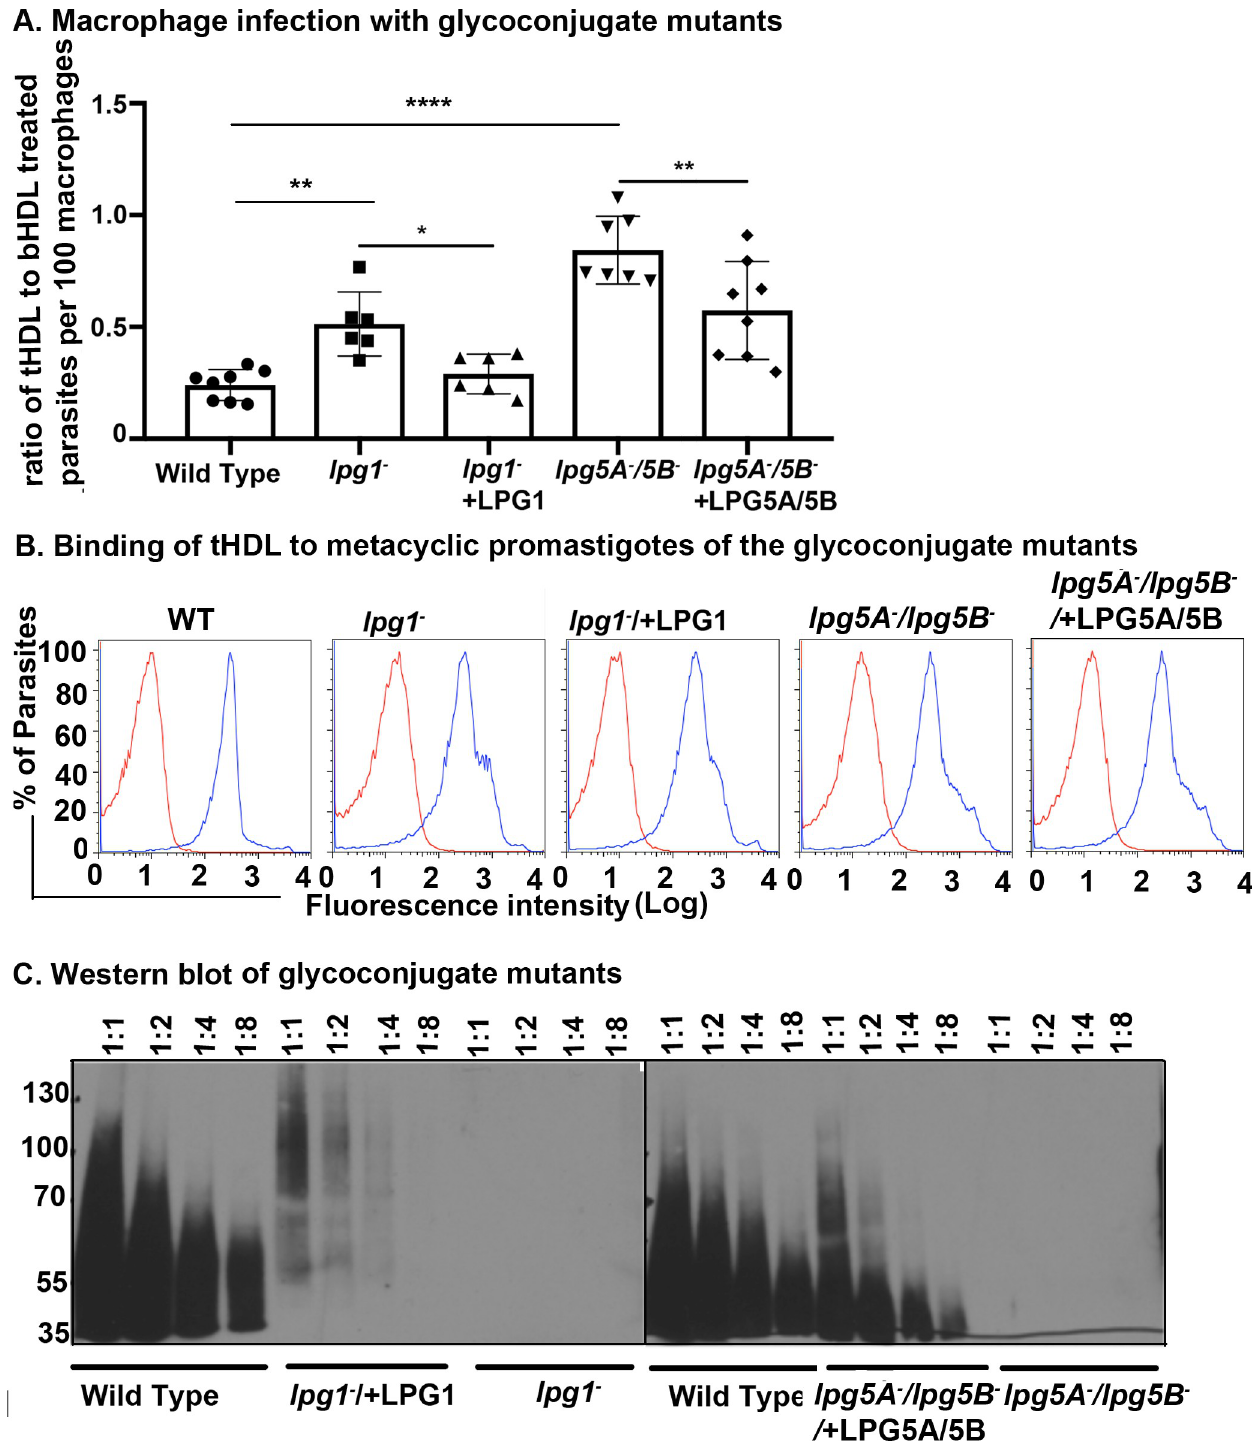
Fig 5. S urface glycoconjugate mutants of L . major are less susceptible to TLF-mediated lysis than wild-type parasites in the macrophage. Metacyclic promastigotes of L . major (WT), the glycoconjugate mutants ( lpg1 - and lpg5A - /lpg5B - ), or the complemented lines ( lpg1 - +LPG1 and lpg5A - /lpg5B - +LPG5A/ 5B) were: A. used to infect macrophages in the presence of human HDL(tHDL) or bovine HDL (bHDL) (1.5 mg/ml). Parasites were counted in macrophages at 24 hours post-infection by staining with DAPI. The y-axis represents the ratio of parasites per 100 macrophages resulting from tHDL treatment compared to bHDL treatment. The data are representative of three experiments combined, � p < 0.05, �� p < 0.001, and ���� p < 0.0001. ANOVA test, multiple